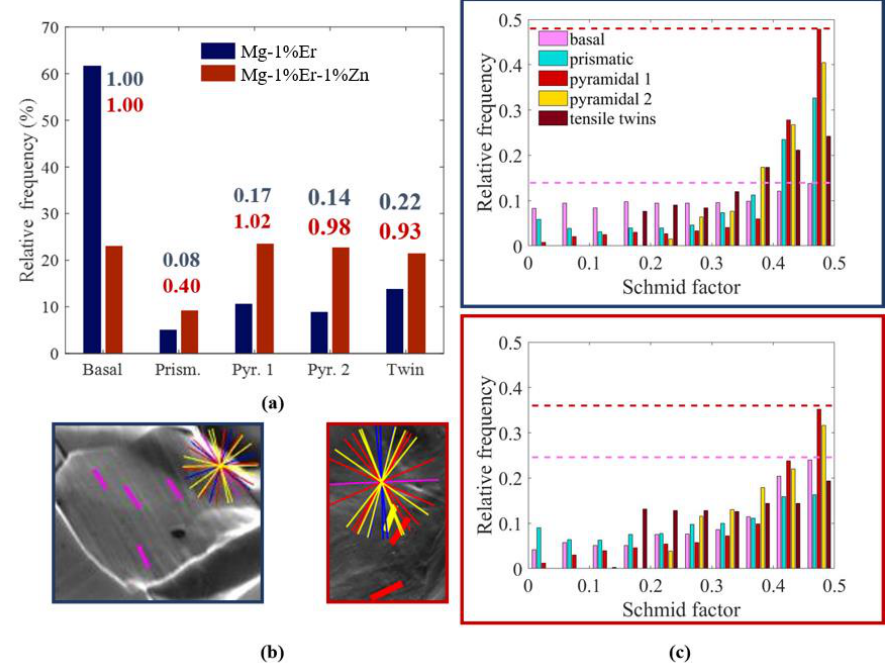
Figure 12. ( a ) Distribution of slip traces corresponding to the active slip systems in Mg-1%Er and Mg-1%Er-1%Zn during tension to 5% strain. The initial condition of the sample corresponded to annealing at 400 °C for 60 min. ( b ) Exemplary SE images of one grain exhibiting the morphology of slip traces with overlaid possible slip systems obtained from EBSD for the determination of the active slip system. ( c ) Schmid factor distribution calculated from the initial texture of the grains, in which the slip traces were detected in both alloys.